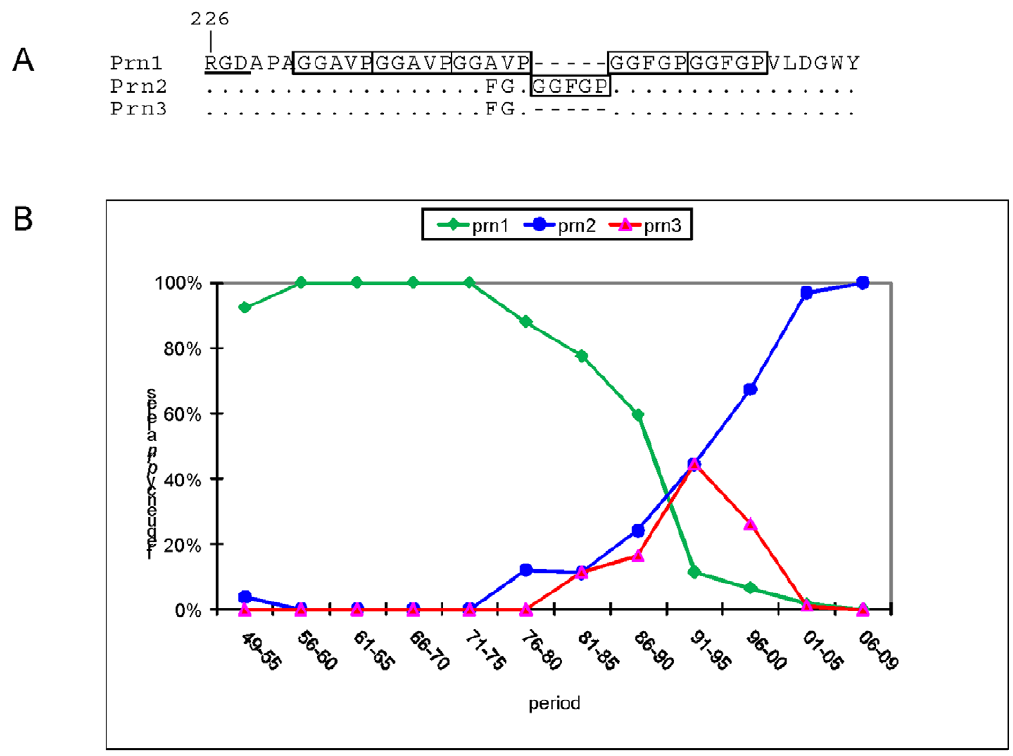
Figure 1. Variation in pertactin (A) and temporal trends in the frequency of pertactin alleles (B). The number in the pertactin sequences indicates the amino acid position relative to the N-terminus. The RGD motif implicated in binding to host receptors has been underlined. Repeat motifs are blocked. Dots and dashes indicate sequence identity with Prn1 and gaps, respectively. No strains were available from the period 1960-1964 to determine allele frequencies. Vaccination against pertussis was introduced in 1953.